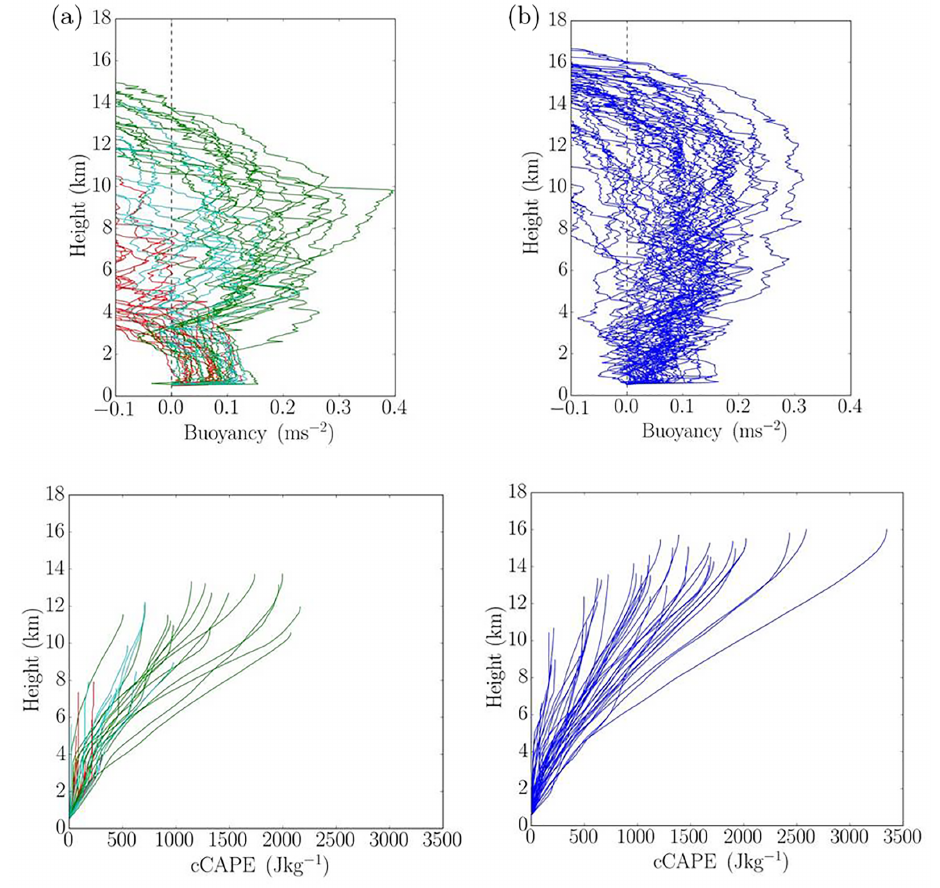
Figure 4. Profiles of the pseudo-adiabatic buoyancy (upper panels) and cCAPE (lower panels) for pre-monsoon (a) and monsoon (b) sound- ings. cCAPE profiles terminate at LNB. Pre-monsoon soundings are divided into three groups marked by red, light blue, and green lines, depending on the CAPE